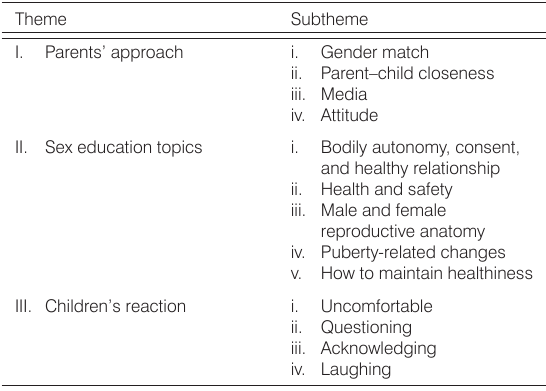
Table 2. Theme and